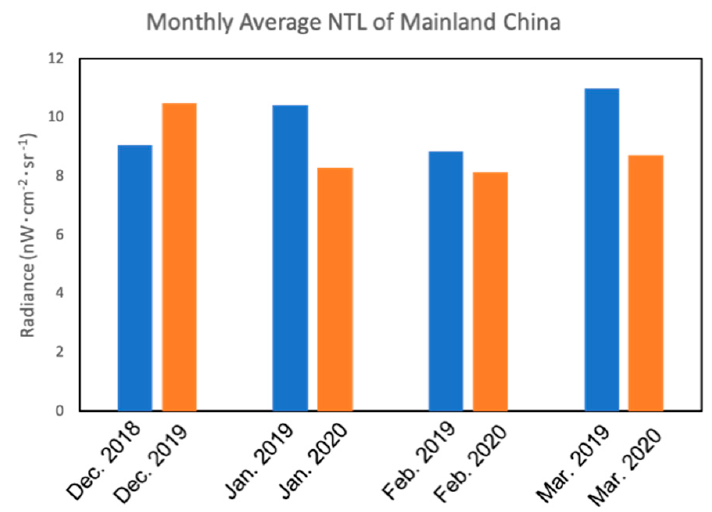
Figure 3. Monthly mean NTL of mainland China from December 2019 to Mach. 2020. The same period of data from December 2018 to March 2019 is also plotted as a reference to see how the nighttime light changes during the pandemic.